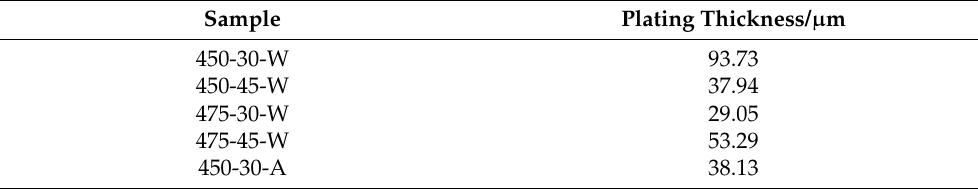
Figure 2. Metallographic organization of hot dip coated steel wire with different process parameters under metallographic microscope, ( a ) 450-30-W; ( b ) 450-45-W; ( c ) 475-30-W; ( d ) 475-45-W; ( e ) 450-30-A. Table 5. Measurement results of hot dip coating thickness under different process parameters.